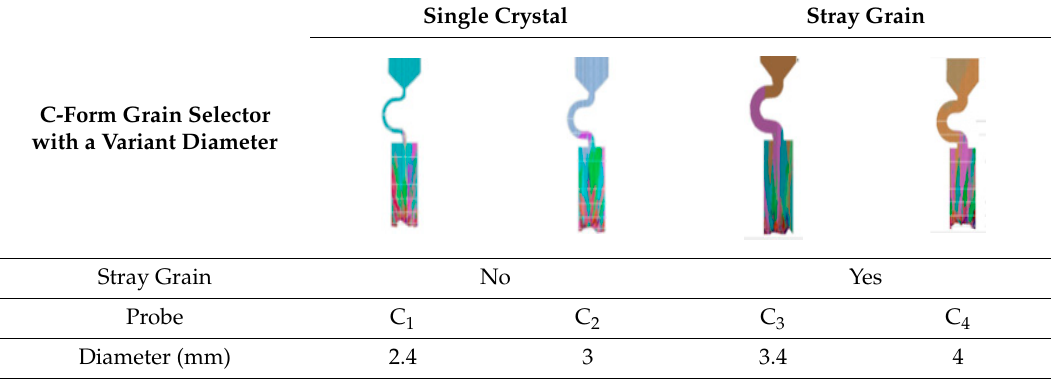
Table 3. Variant pitch length parameters of C-form selectors.